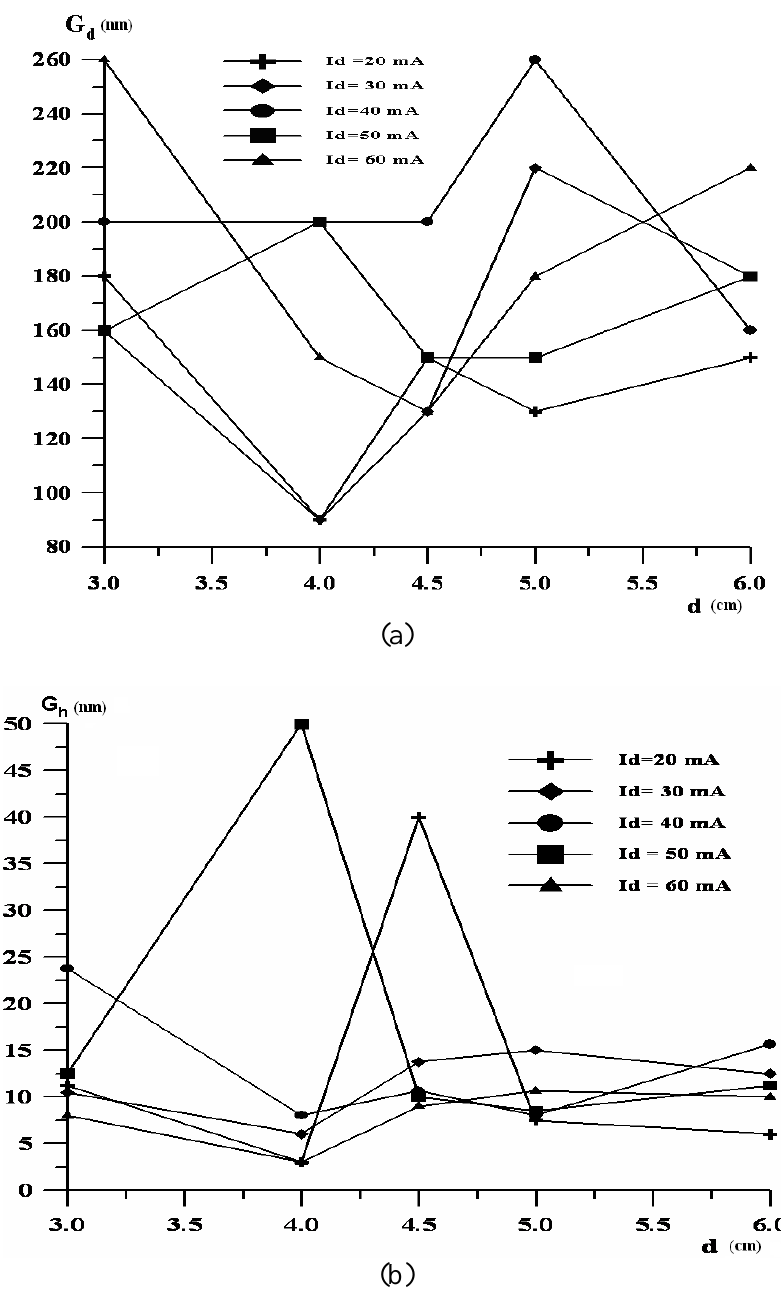
Fig.9: Effects of variation of sputtering current with electrode separations on a- average gold grain diameter b- average gold grain